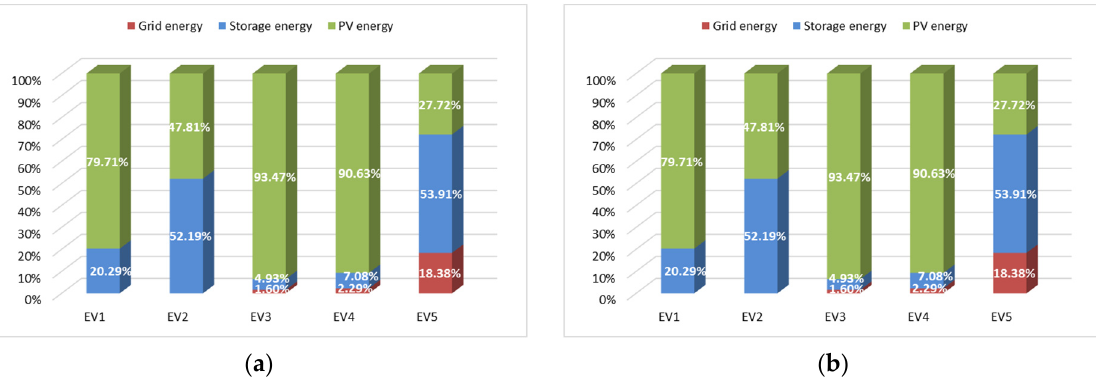
Figure 7. EV energy distribution in ( a ) “Sim w/o opt” and ( b ) “Sim with opt”—case 1.